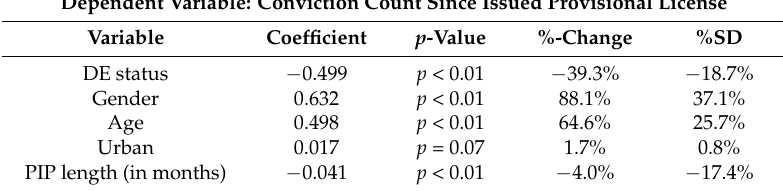
Table 4. Results from Poisson analysis of convictions since issued provisional